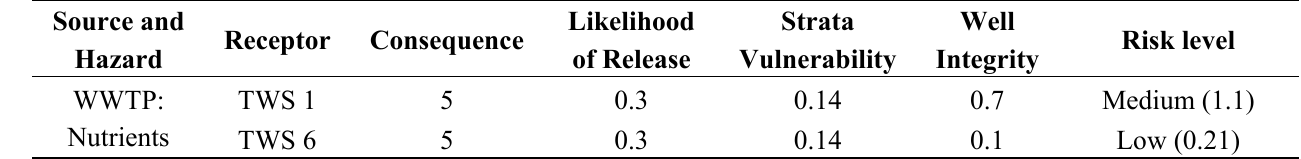
Table 8. Summary of risk assessment for TWS 1 and TWS